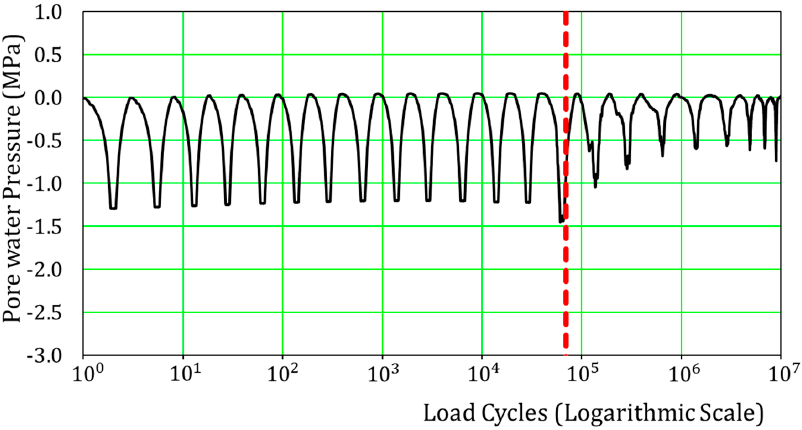
Figure 11. Load cycles and the pore water pressure of the central zone of the RC deck.